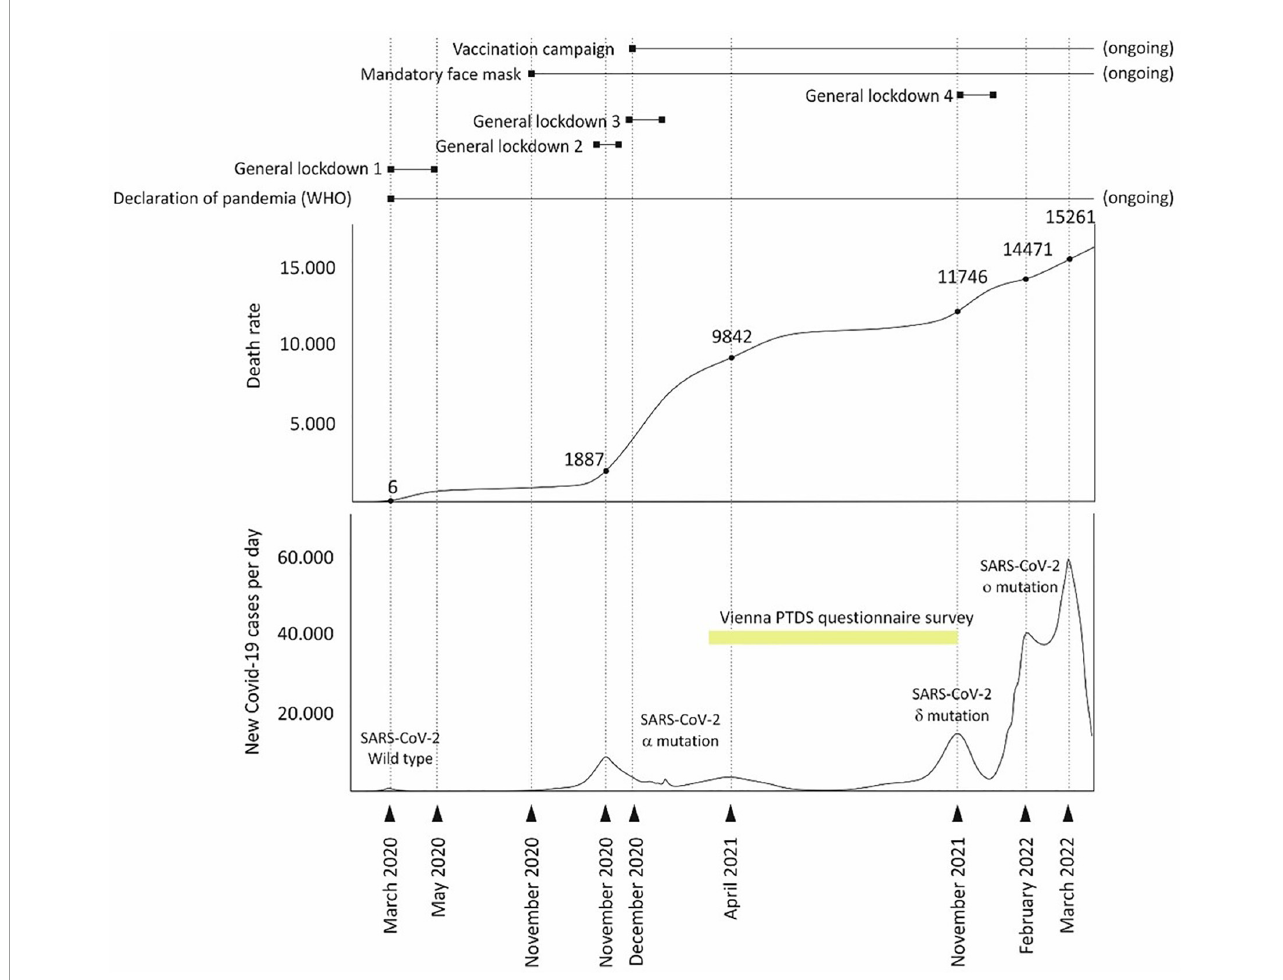
FIGURE1 Timing of the Vienna post-traumatic stress disorder (PTSD) questionnaire survey during the COVID-19 pandemic in Austria.